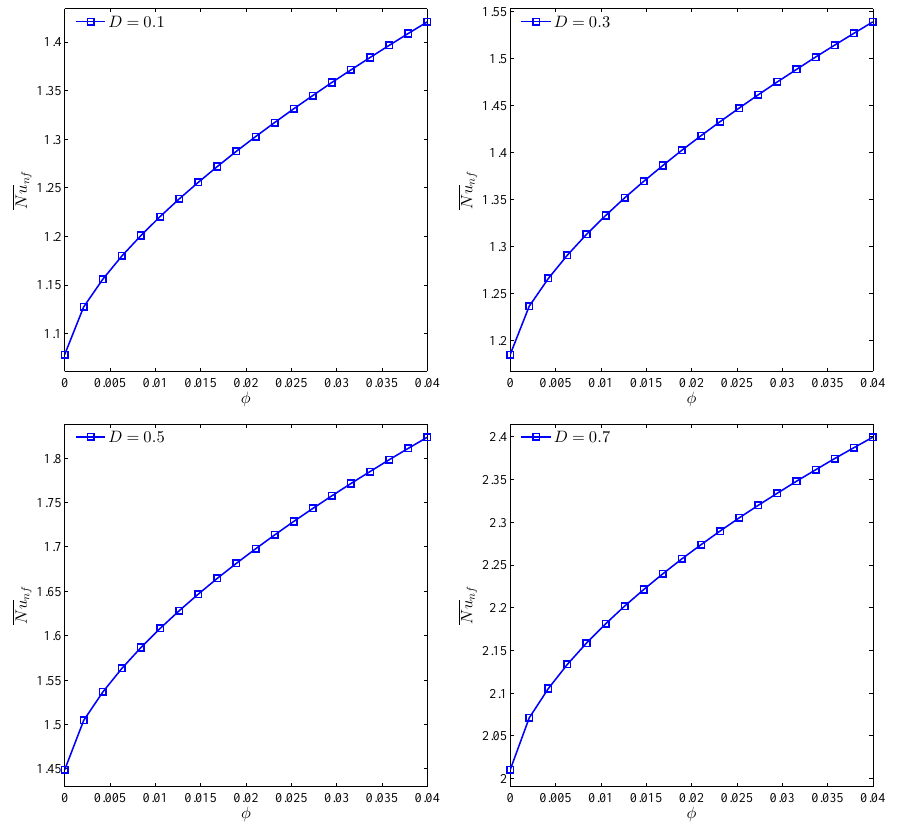
Figure 16. Variation of average Nusselt number with φ for different D at Ra = 10 2 and k w =